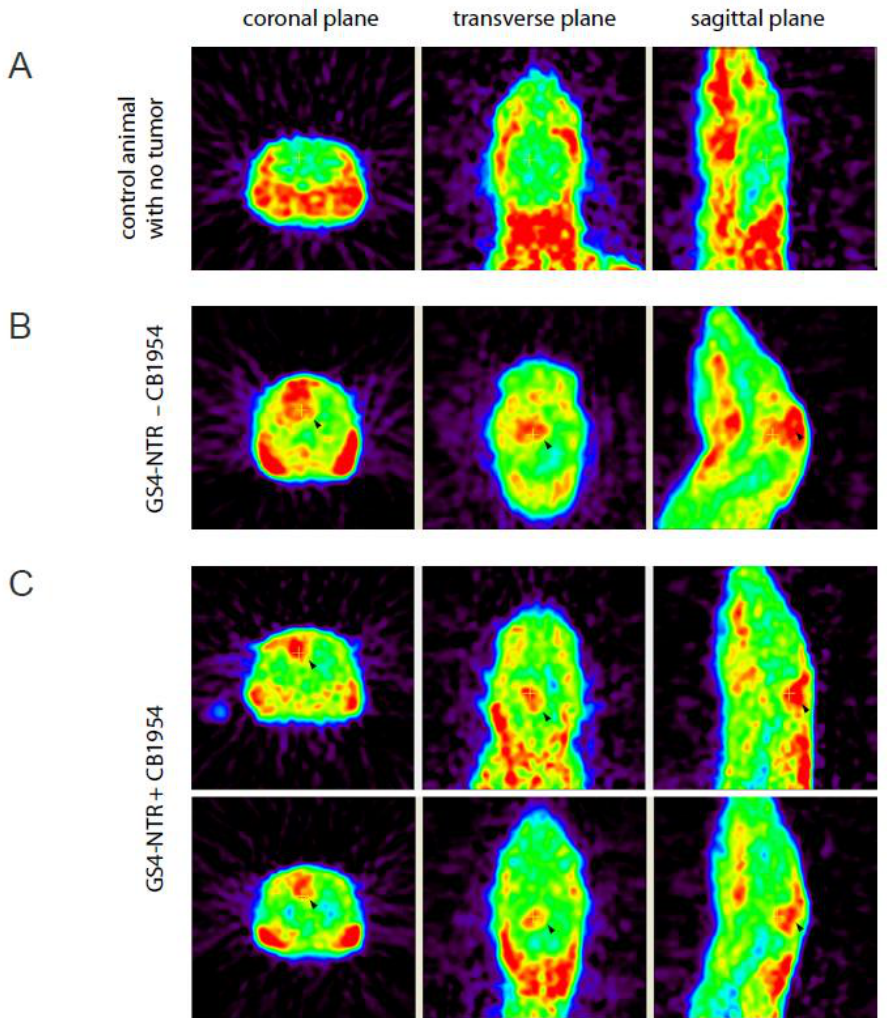
Figure 5. MicroPET imaging of intracerebral RG-2 glioma-bearing rats. MicroPET imaging of L-[ 18 F] FET in rats was performed using the R4 system, 20 days after intracerebral RG-2 glioma implantation. Representative examples comparing microPET imaging results from non-tumor-bearing rats ( A ), tumor-bearing rats treated with GS4-NTR but without prodrug administration ( B ), or tumor-bearing rats with GS4-NTR and CB1954 prodrug treatments ( C ) are shown, and tumor regions are indicated by arrowheads. The tumor uptake of L-[ 18 F] FET in the GS4-NTR − CB1954 group relative to the GS4-NTR + CB1954 group was 2.015-fold ( p < 0.01).